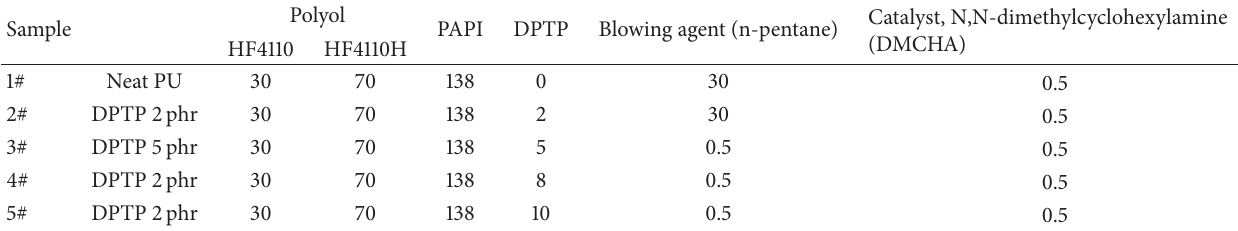
Table 1: Formulations of RPUF.